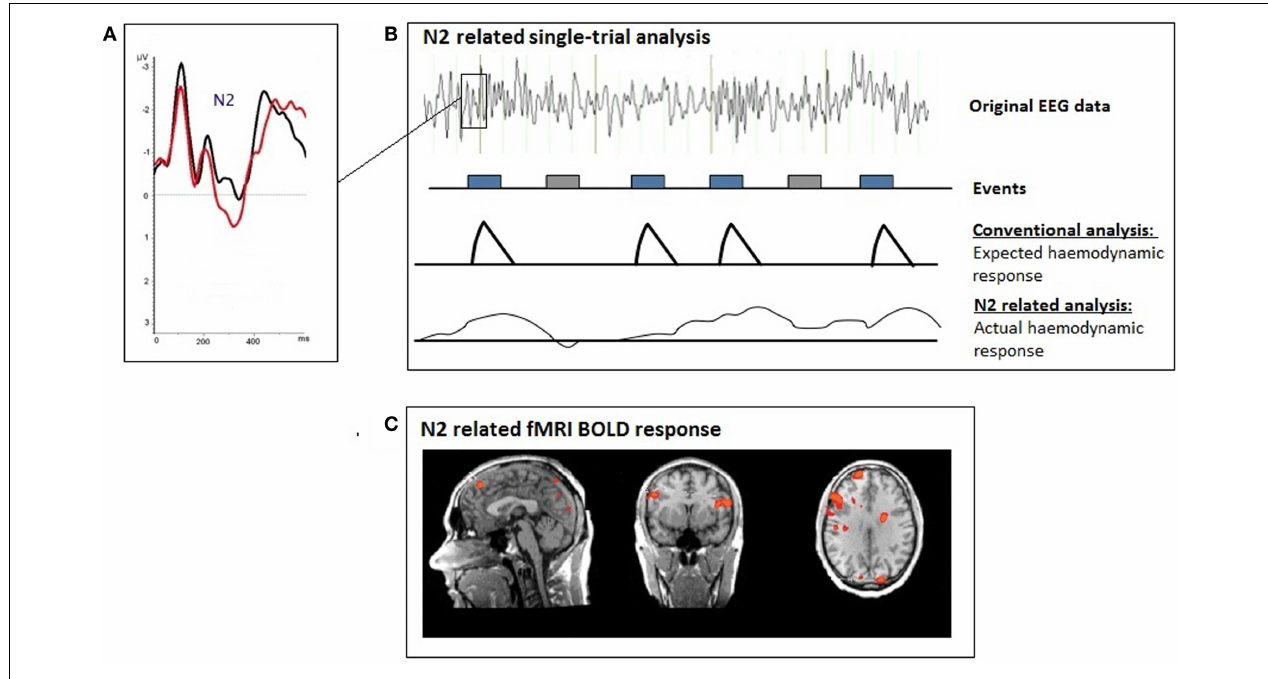
were used for the single-trial GLM analyses; (C) single-trial N2-related fMRI response during voluntary selection between different response alternatives .